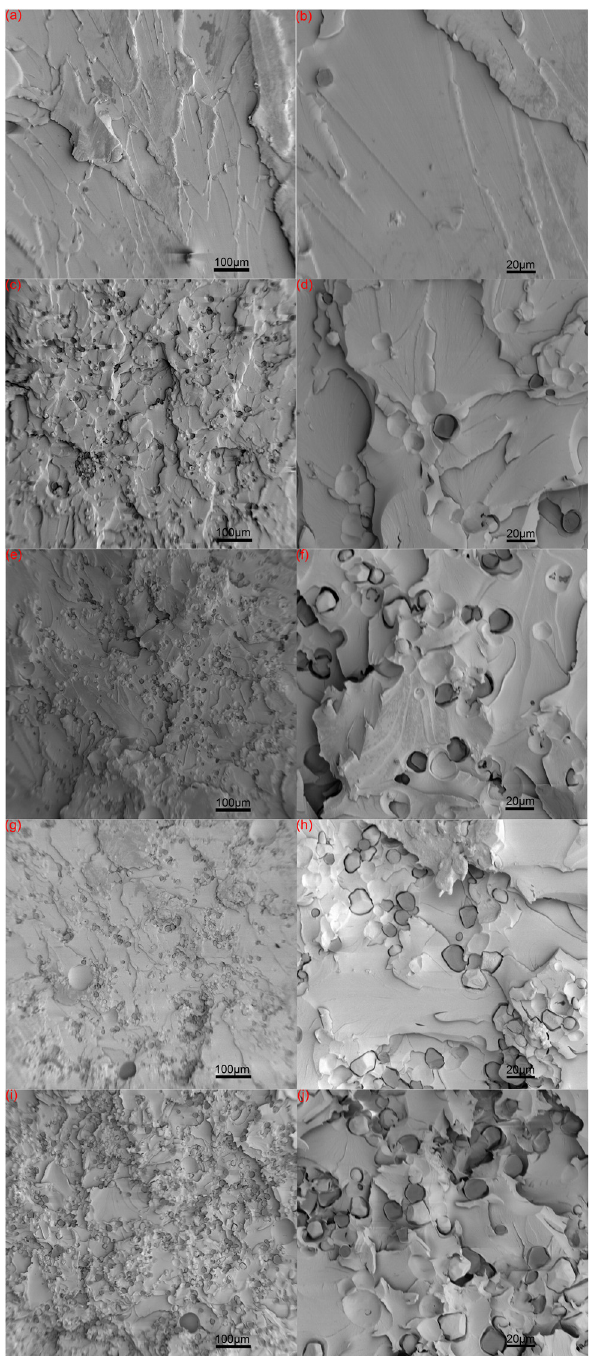
Figure 4: Micrographs of tensile fractured surfaces of specimens: